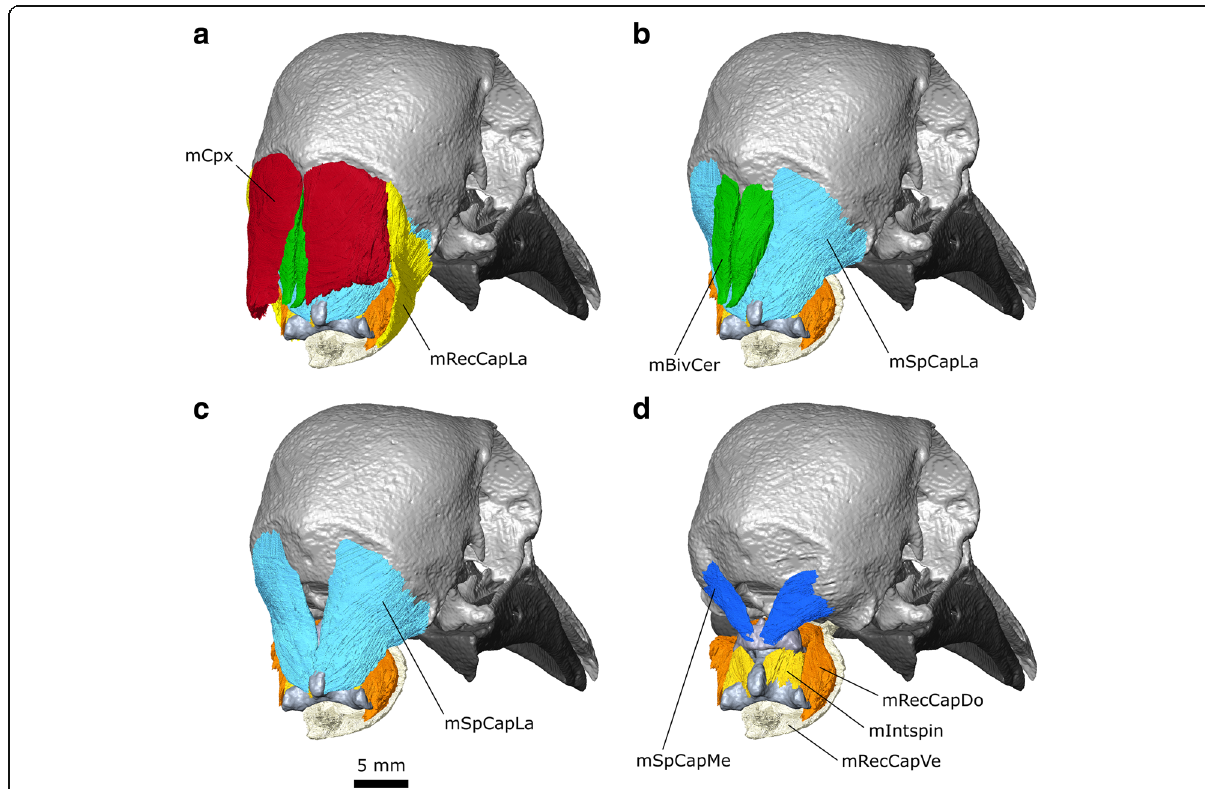
Fig. 17 The anterior neck muscles of Columba livia in dorsal view. a to c represent increasingly deep